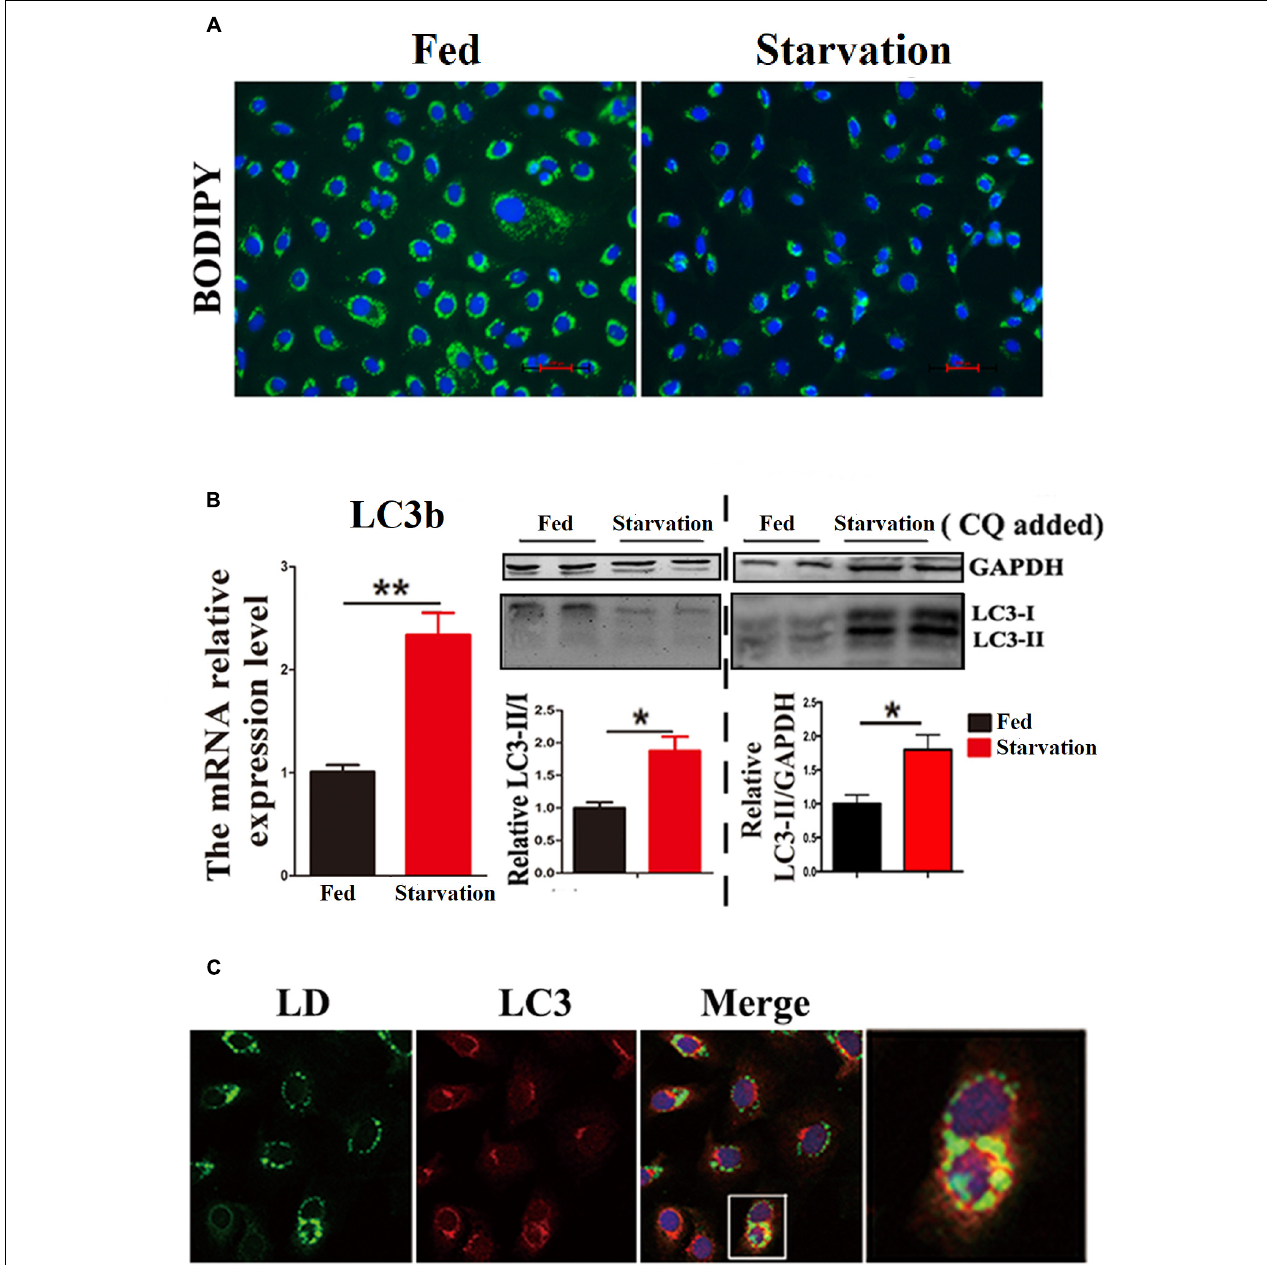
FIGURE 1 | Starvation induces lipophagy in ZFL cell line. (A) Lipid droplets (LDs) stained with BODIPY 493/503 (green) in ZFL cell line in starvation condition. (B) The mRNA expression, immunoblot and densitometric analysis of LC3 in the samples in ZFL cell line. ( ∗ P < 0.05, ∗∗ P < 0.01, n = 6). Error bars, SEM. (C) Co-localization of BODIPY 493/503 (green) with LC3 (red) in ZFL cell line in starvation condition. Nuclei are highlighted with 4, 6-diamidino-2-phenylindole